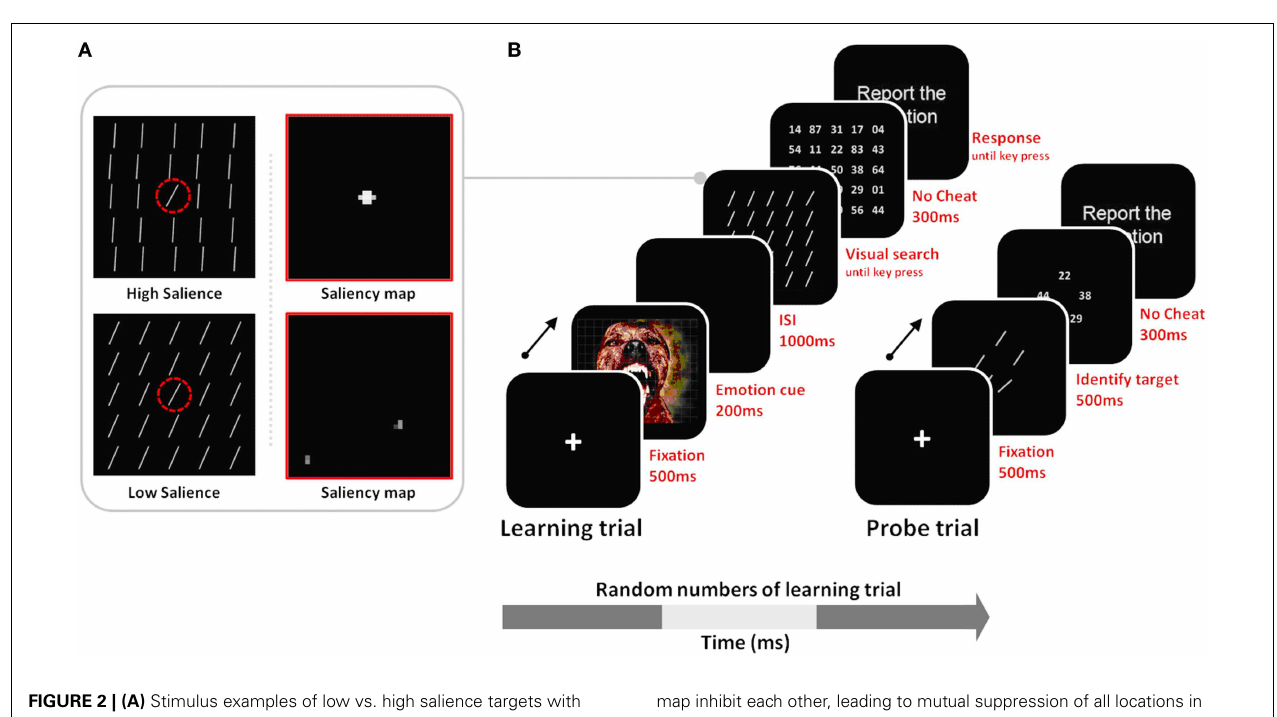
FIGURE 2 | (A) Stimulus examples of low vs. high salience targets with their corresponding saliency maps derived from Itti and Koch’s (2000) computational model. For the high-salience condition, the distractor lines were tilted at 80˚, creating a 25˚ difference between them and the 55˚ target; therefore iterative spatial competition leads the target’s location to gain further strength while suppressing surrounding regions. In the low-salience condition, the target and the distractor differ in tilt only by 5˚, and therefore the similarly activated locations in the saliency